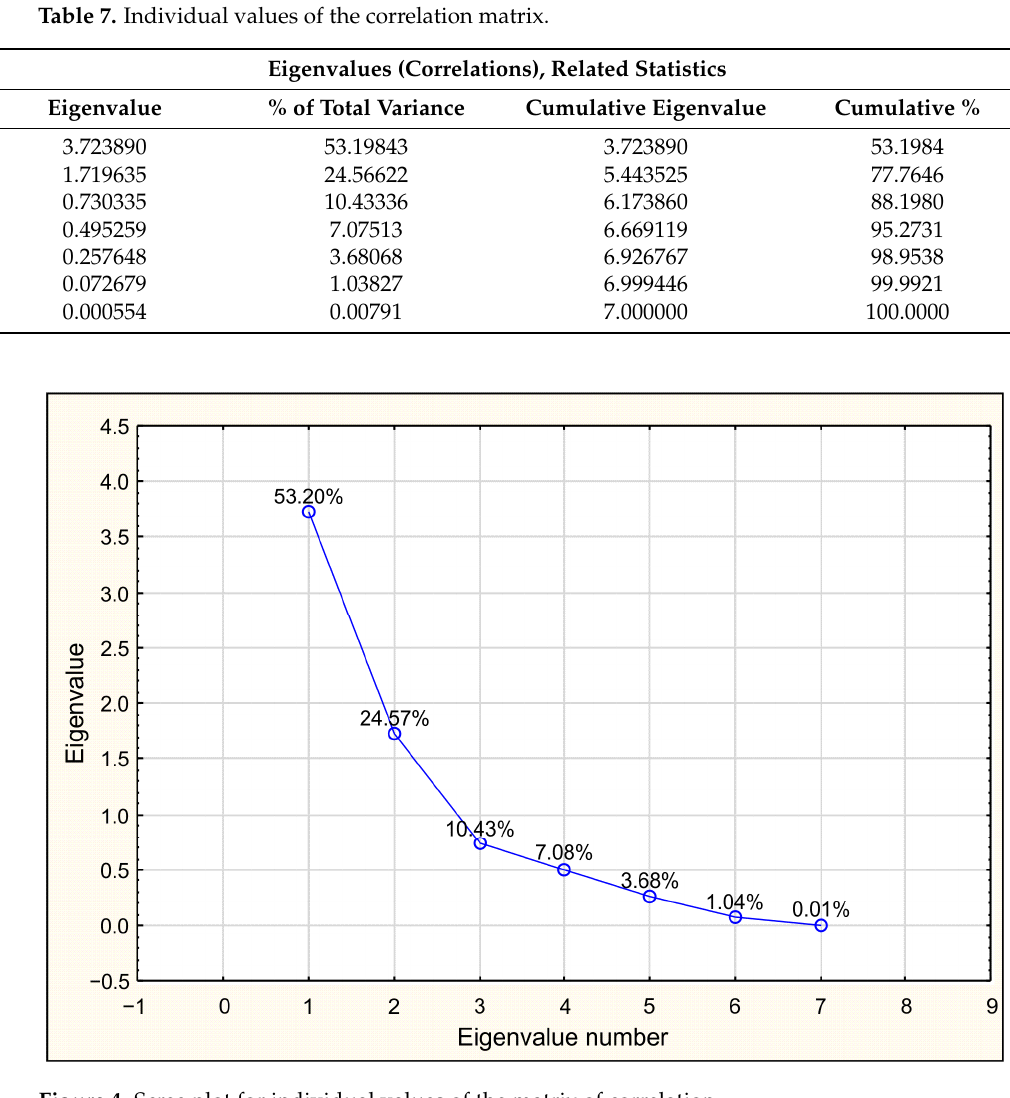
Figure 4. Scree plot for individual values of the matrix of correlation.